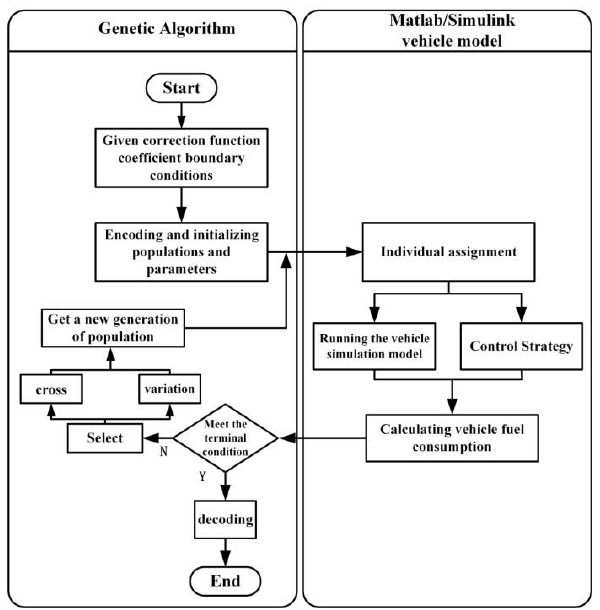
Figure 7. Global optimization model based on GA.